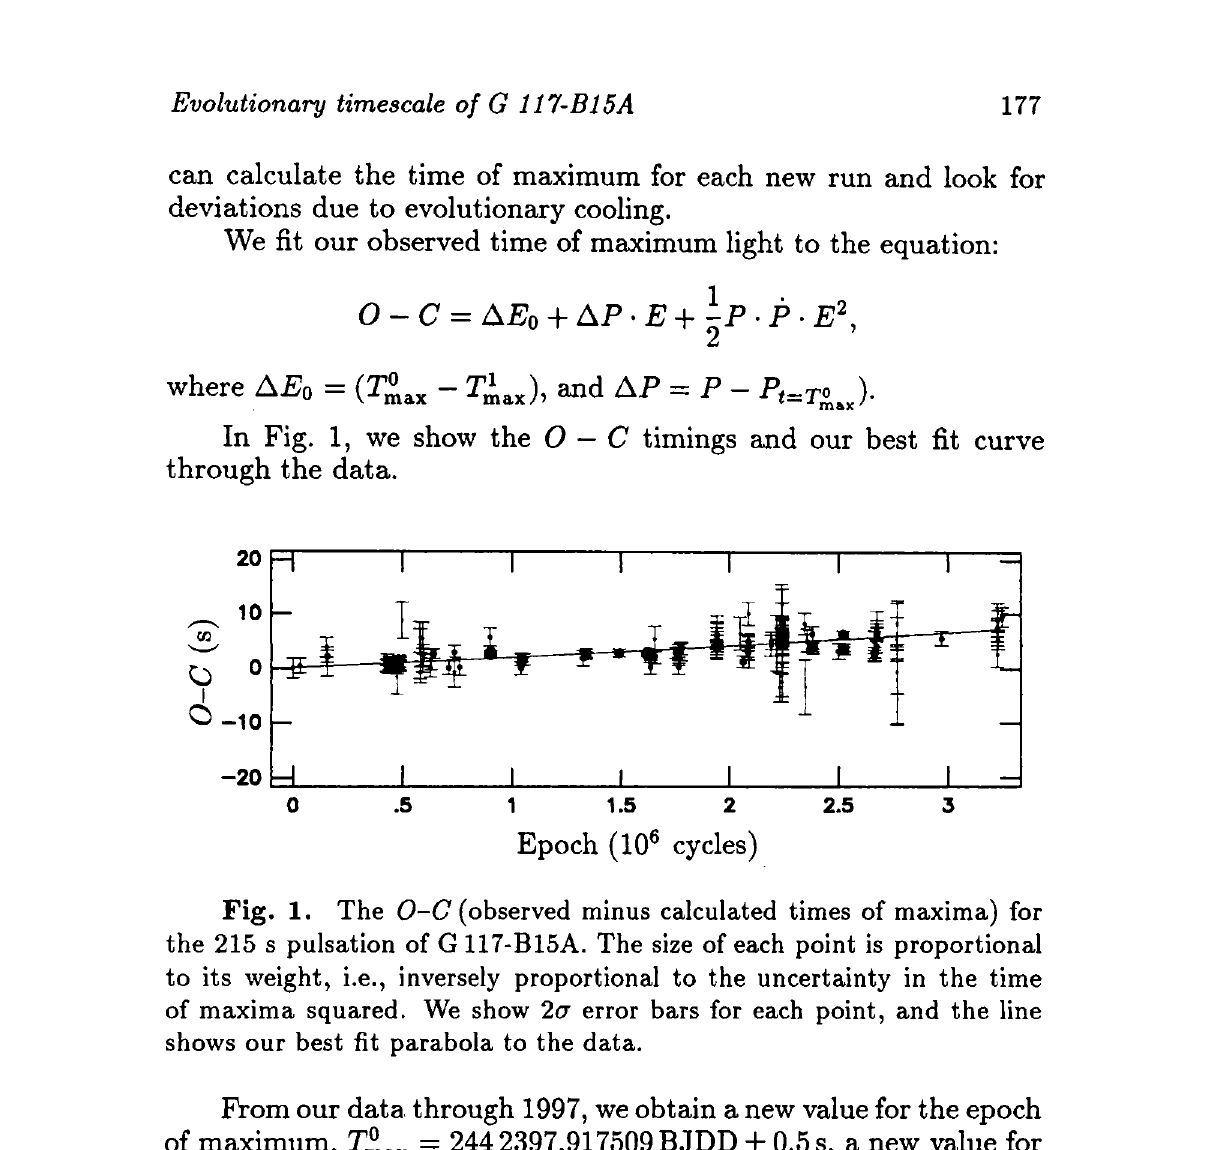
Fig. 1. The 0-C (observed minus calculated times of maxima) for the 215 s pulsation of G 117-B15A. The size of each point is proportional to its weight, i.e., inversely proportional to the uncertainty in the time of maxima squared. We show 2a error bars for each point, and the line shows our best fit parabola to the